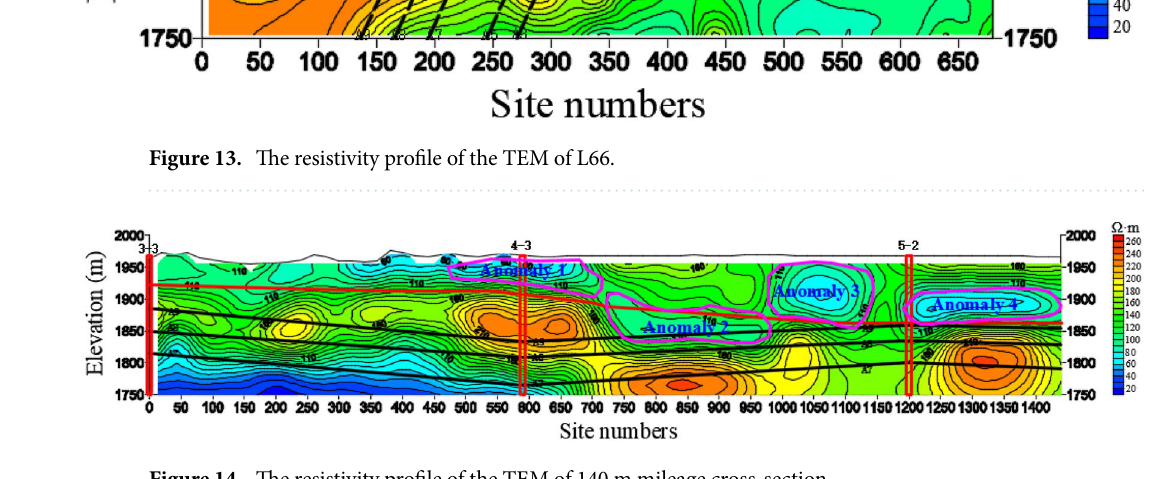
Figure 14. The resistivity profile of the TEM of 140 m mileage cross-section.